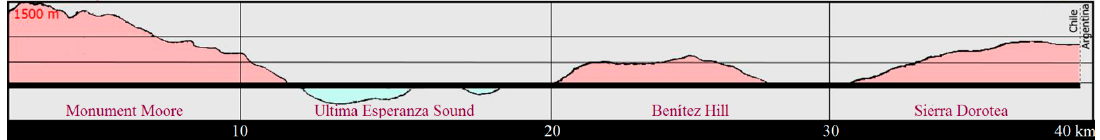
Figure 1. Locations maps of the studied area. ( a ) South America, ( b ) southern Patagonia indicating the Cerro Benitez area with an arrow, ( c ) its location close to the Ultima Esperanza Sound. References: CB: Benitez Hill, LS: Lago Sofía, UES: Ultima Esperanza Sound. Modified after Google and NASA maps.